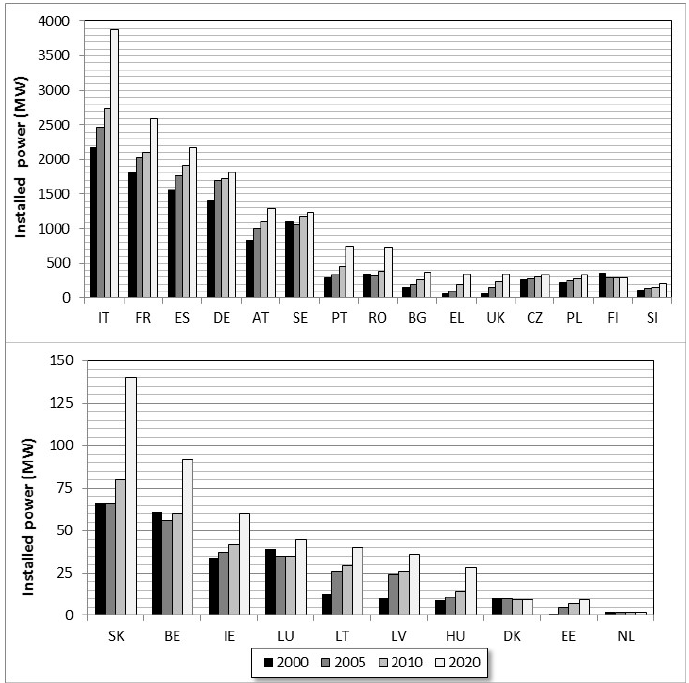
Figure 3. Planned installation of small hydropower capacity in 2005–2020 by European Union countries (adapted from [40]).